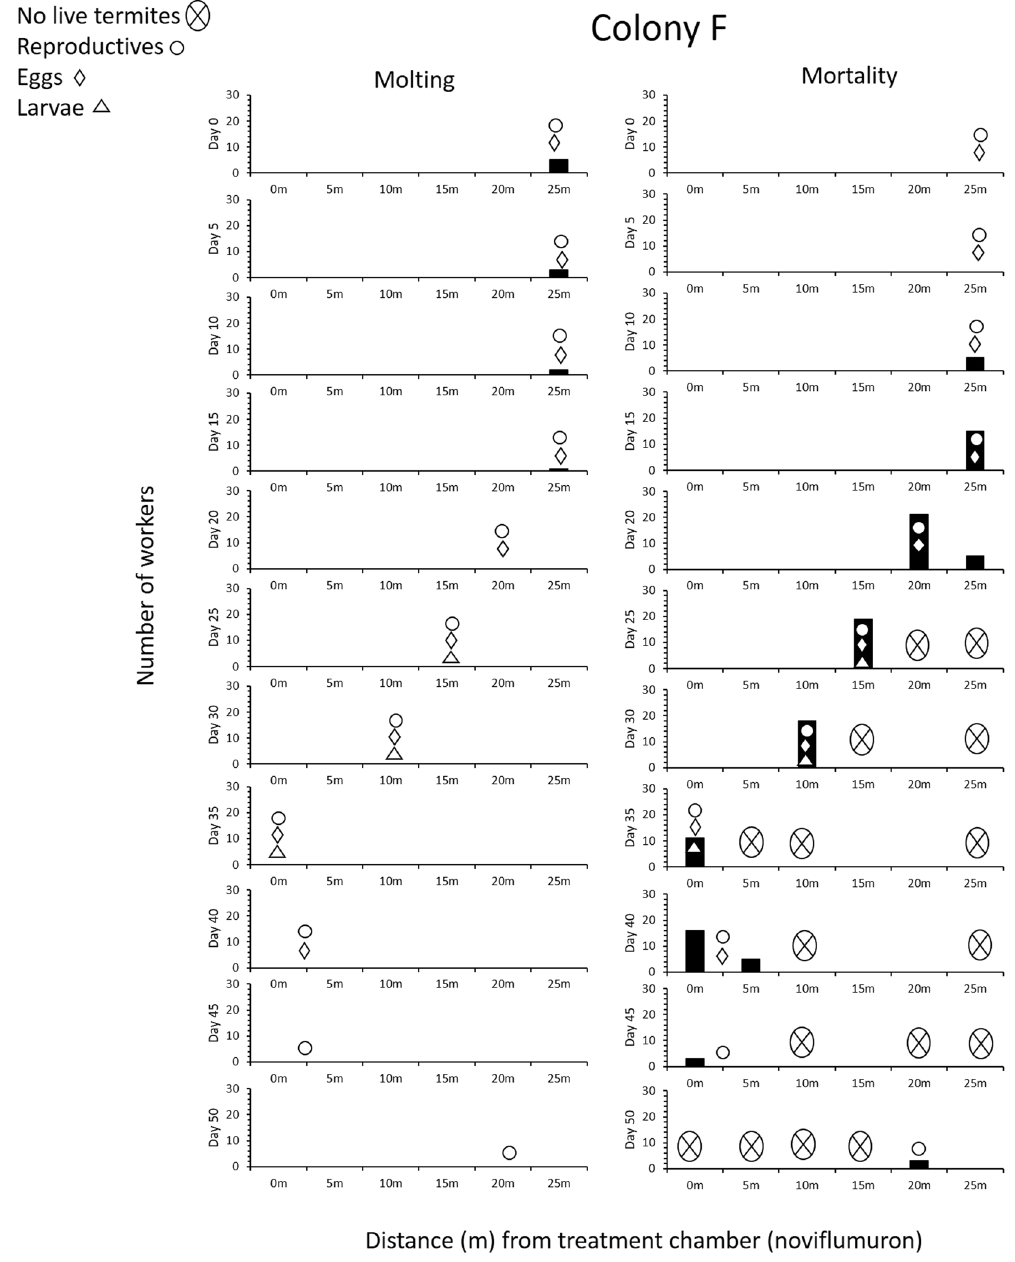
Figure 4. Number of worker molting (left) and worker mortality (right) in a 6 yr old juvenile colony (F) for noviflumuron